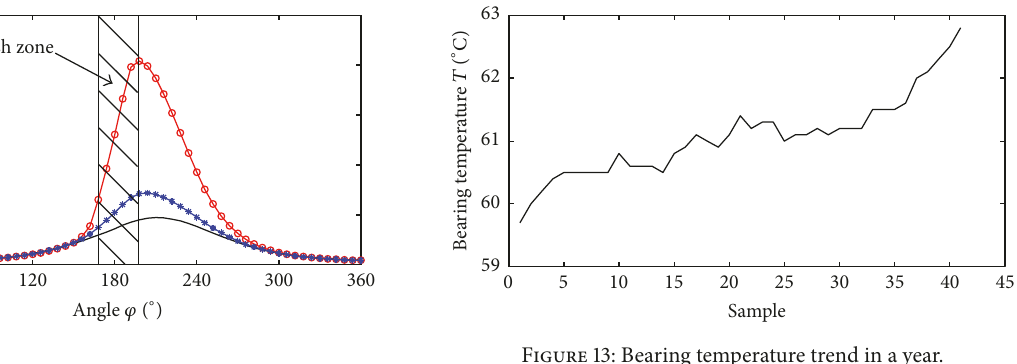
Figure 13: Bearing temperature trend in a year.